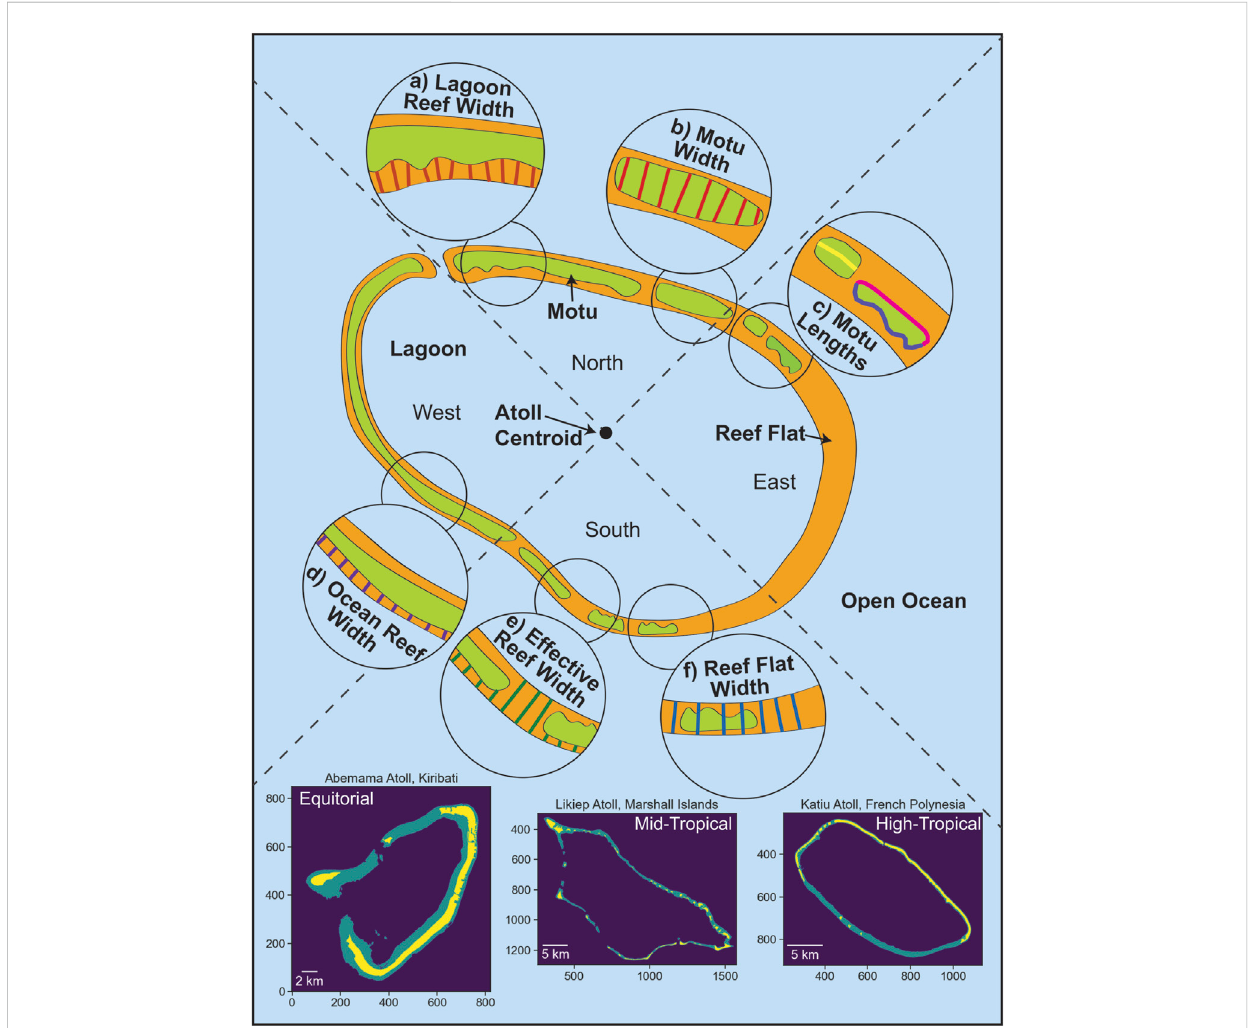
FIGURE 2 Conceptual diagram of morphometrics calculated for idealized atoll classi fi ed into three landcovers: light green (subaerial land, motu), light orange (reef fl at),and lightblue(water). (A) Motu to lagoon-side reef- fl at width, herein called lagoon reefwidth (dark orange lines); (B) motu width (red lines); (C) all motu lengths including motu length (yellow line), ocean-side motu lengths (pink line), and lagoon-side motu length (blue-purple line). (D) motu to ocean-side reef- fl at width, herein called ocean reef width (purple lines); (E) effective reef- fl at width (green lines); and (F) total reef- fl at width, assuming no land on top, herein called reef- fl at width (blue lines). Approximate location of center of mass of entire atoll object denoted by atoll centroid with resultant segregation of atoll objects by cardinal directions North, East, South, and West as shown by dashed grey lines. Three example Landsat temporal Composites, k-means segregated, are shown at the bottom from atolls of each region, where reef- fl ats are teal, water is purple, and land is yellow, shown north-oriented with a